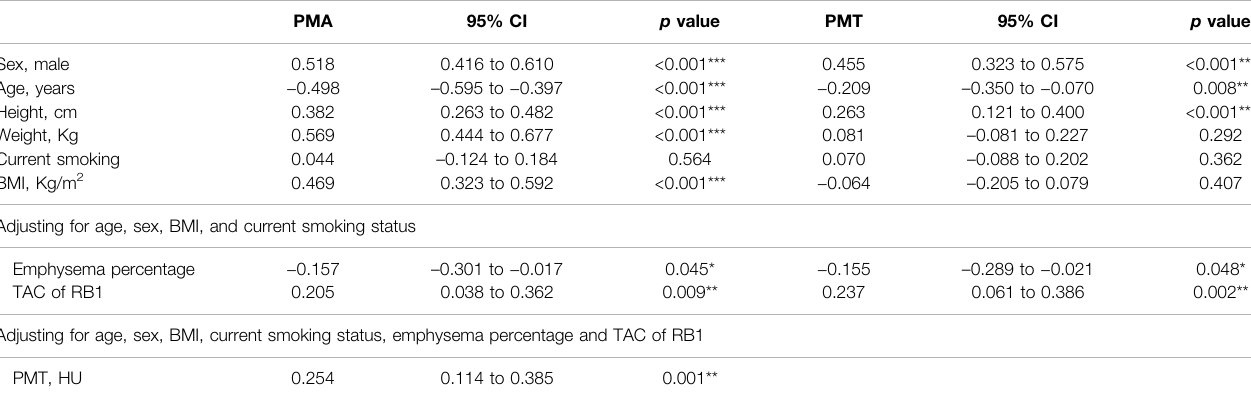
TABLE 3 | Correlation assessment between PMA and PMT measurements and baseline characteristics in